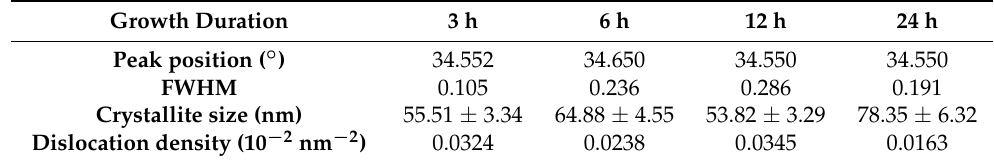
Table 2. Peak position, full width at half maximum (FWHM), crystallite size, and dislocation density of ZnO nanorods after 3 h, 6 h, 12 h and 24 h of